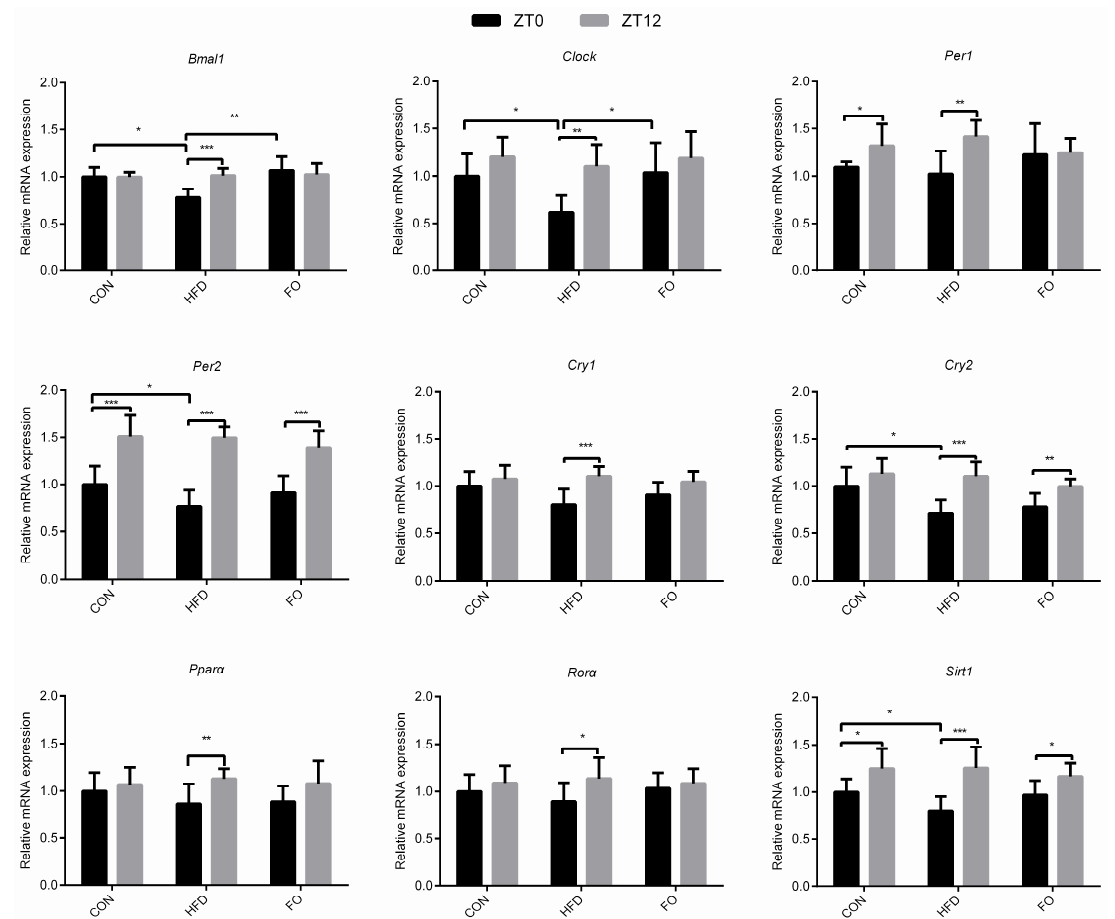
Figure 8. Rhythmic expression of Bmal1 , Clock , Per1/2 , Cry1/2 , Rorα , Pparα and sirt1 genes. Data were expressed as mean ± SD ( n = 10 per group). * p < 0.05, ** p < 0.01, *** p < 0.001.